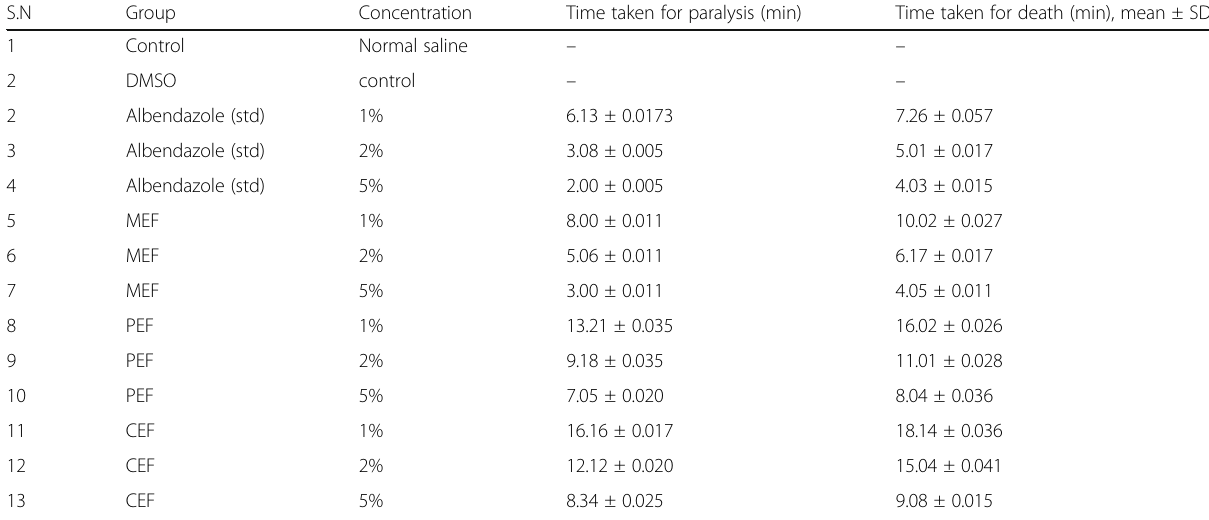
Table 1 In vitro antihelminthic activity of Praecitrulus fistulosus fruit S.N